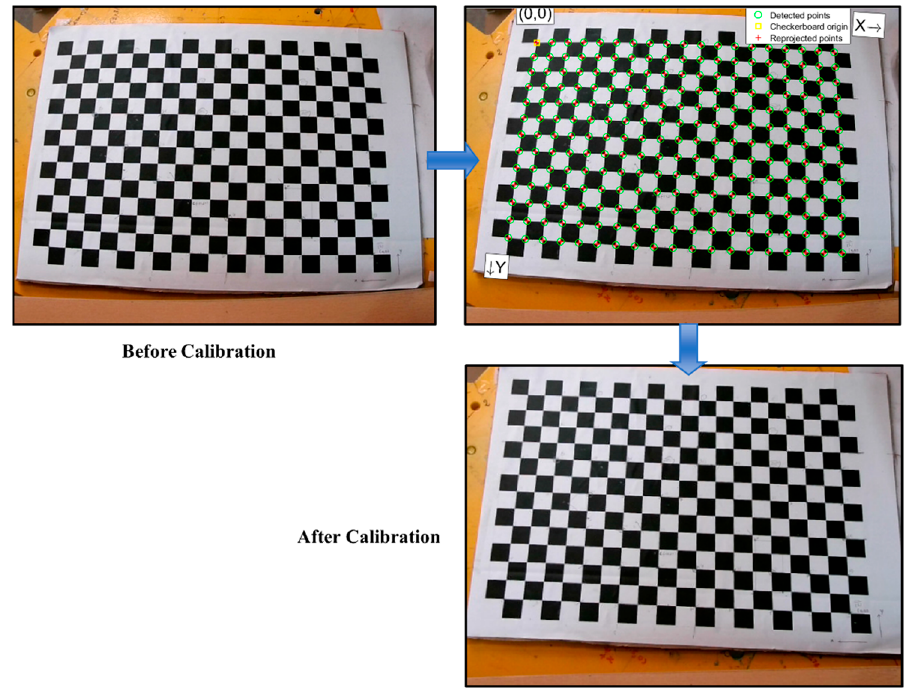
Figure 1. Calibration of Eye-to-Hand Camera Tilted at 26°. The pattern centric and camera centric view of during the calibration process is shown in Figure 2a,b.